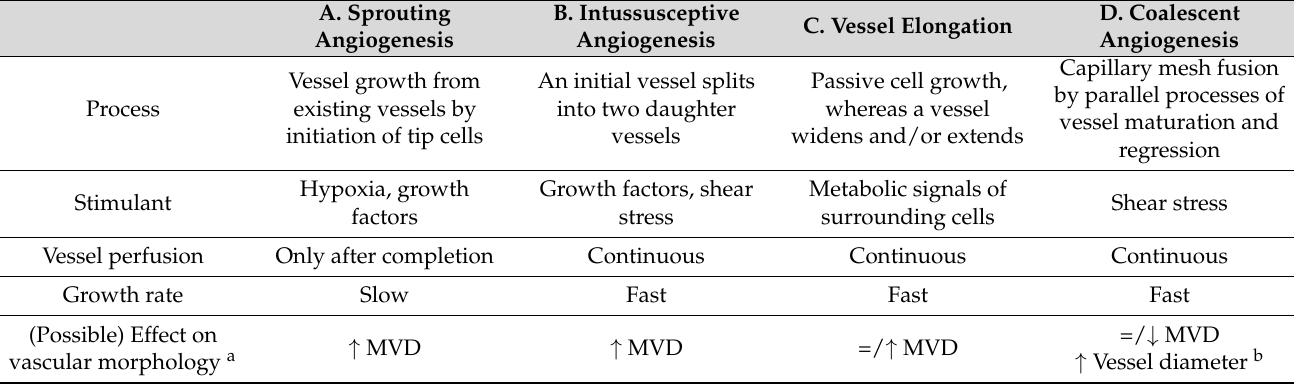
Figure 1. Different types of angiogenesis. Created with BioRender.com. Table 1. Characteristics of the different types of angiogenesis